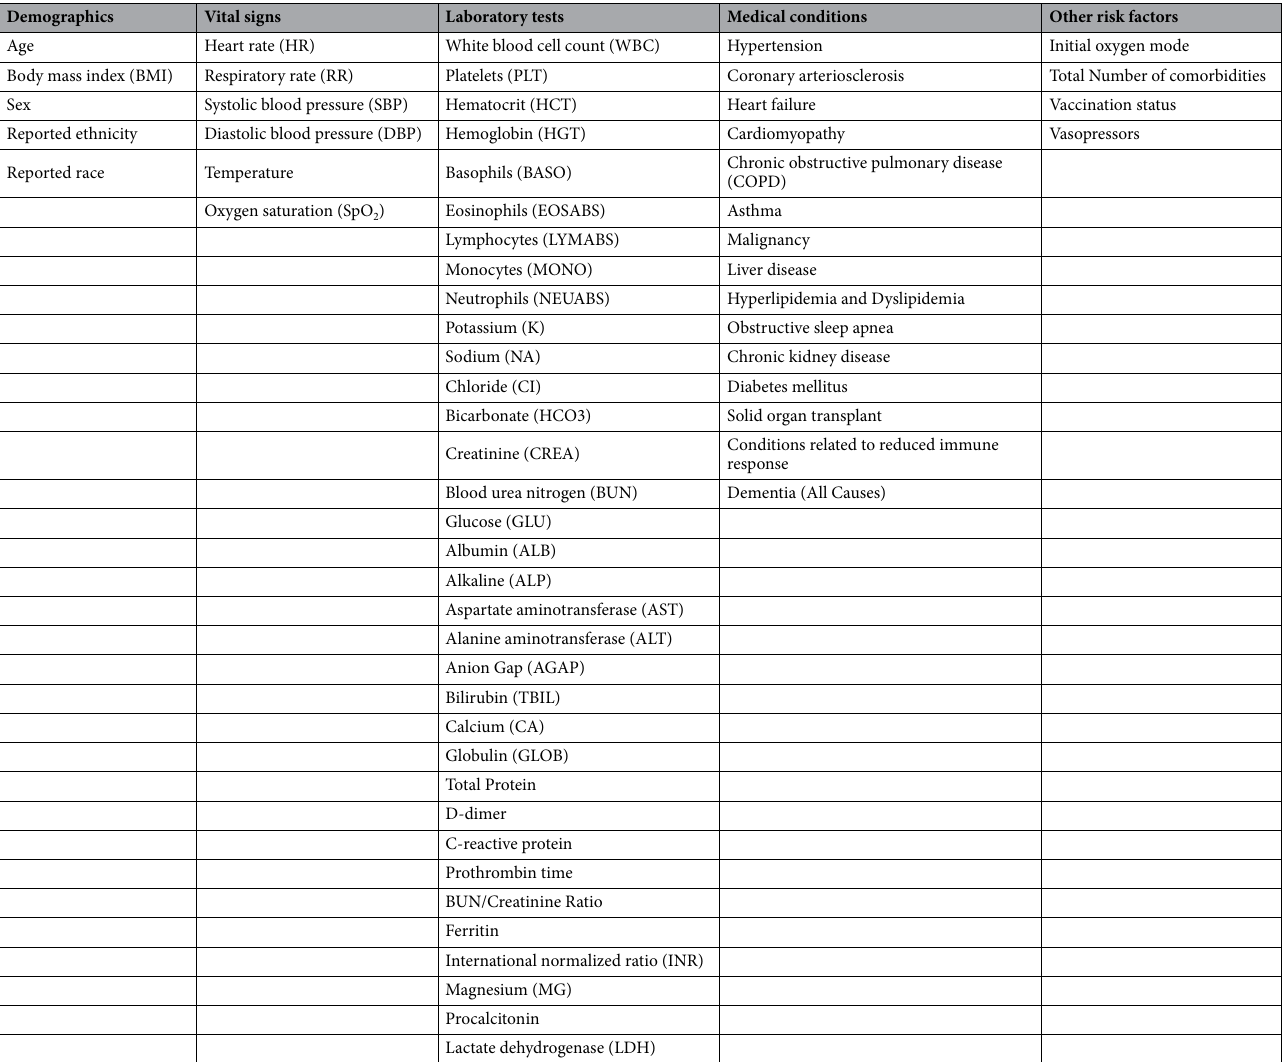
Table 1. Demographics, vital signs, laboratory tests, and medical conditions analyzed for SARS-CoV-2 positive